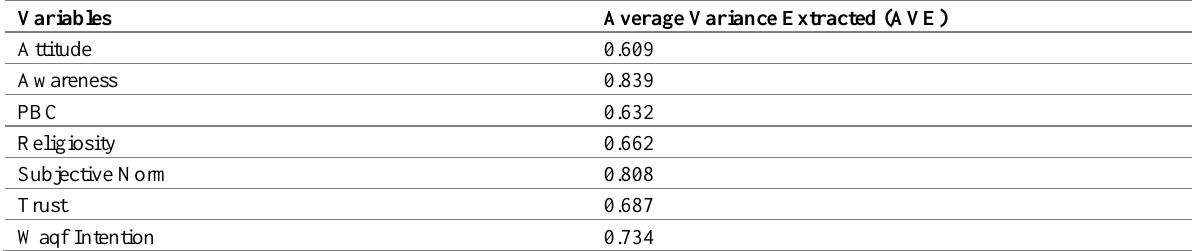
Table 3: Average Variance Extracted